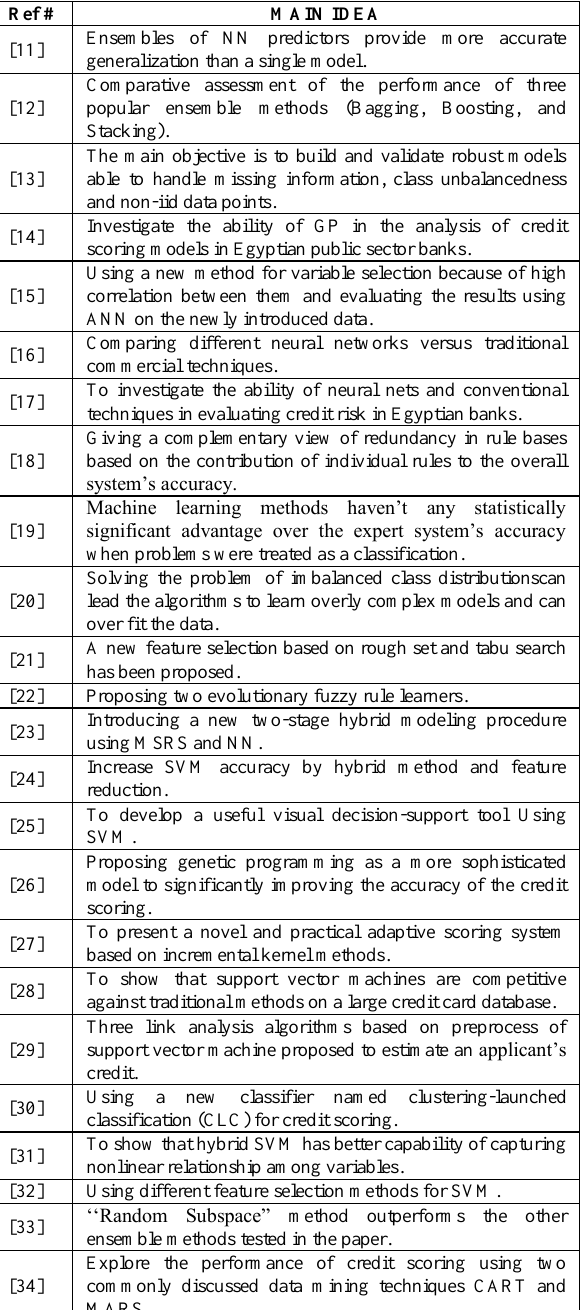
Table 2. Distribution of articles by their main